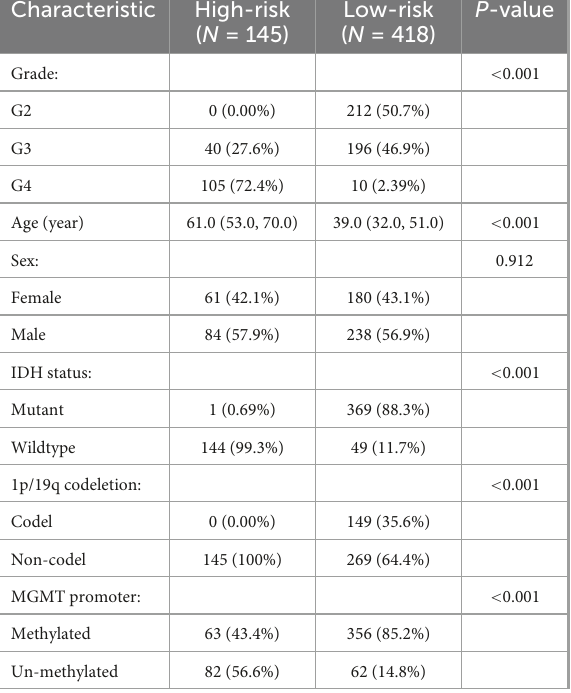
TABLE 1 Characteristics of patients in low- and high-risk groups in the training cohort.